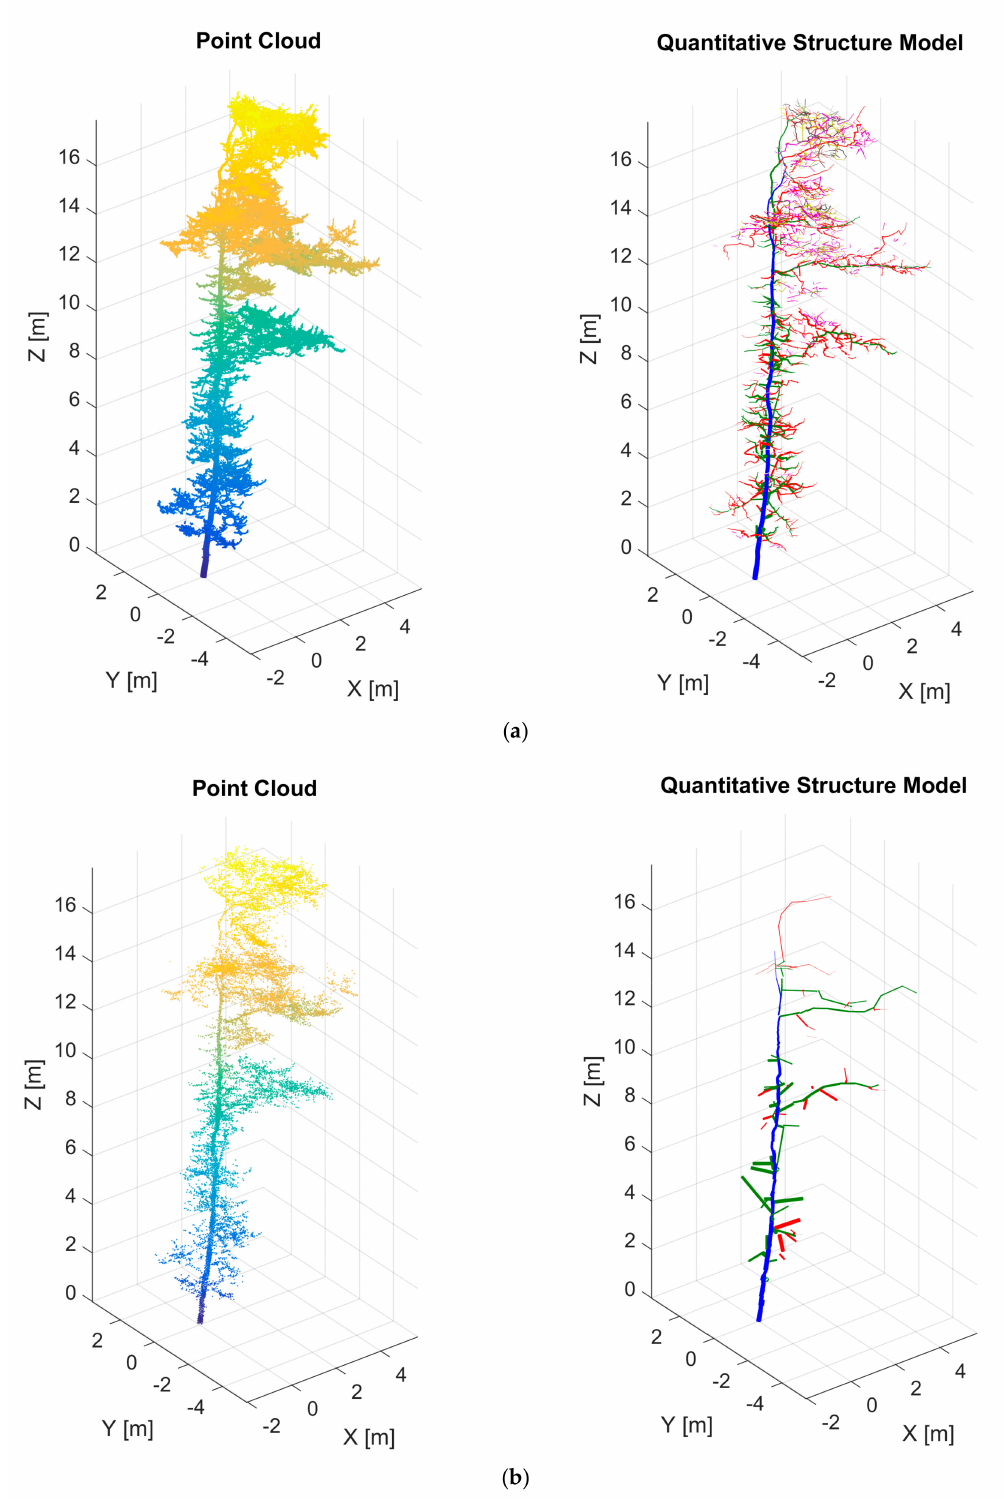
Figure A3. Segmented tree point clouds of a Carpinus betulus tree with the extracted QSM of the leaf-off datasets of plot 1: ( a ) TLS; ( b )